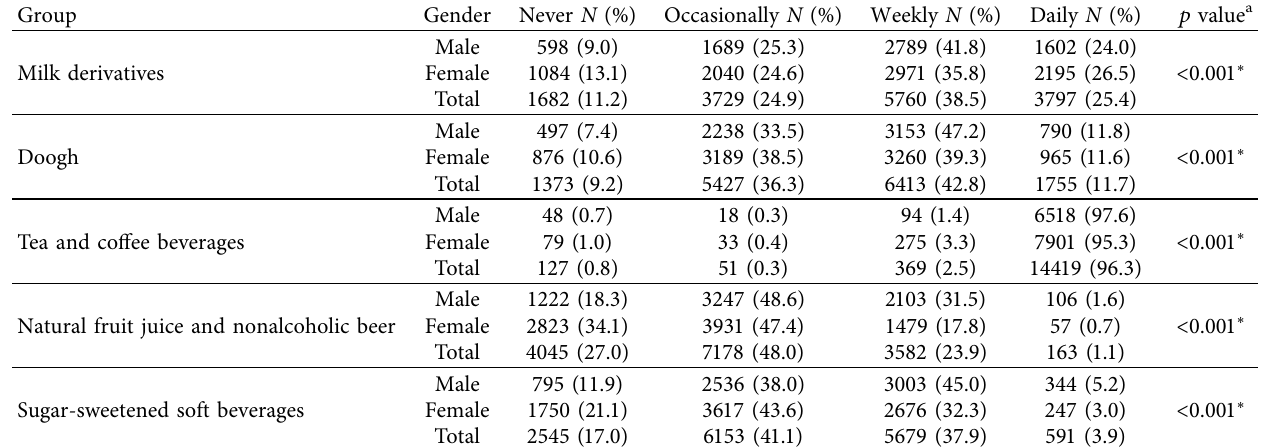
Table 1: Beverage consumption status in